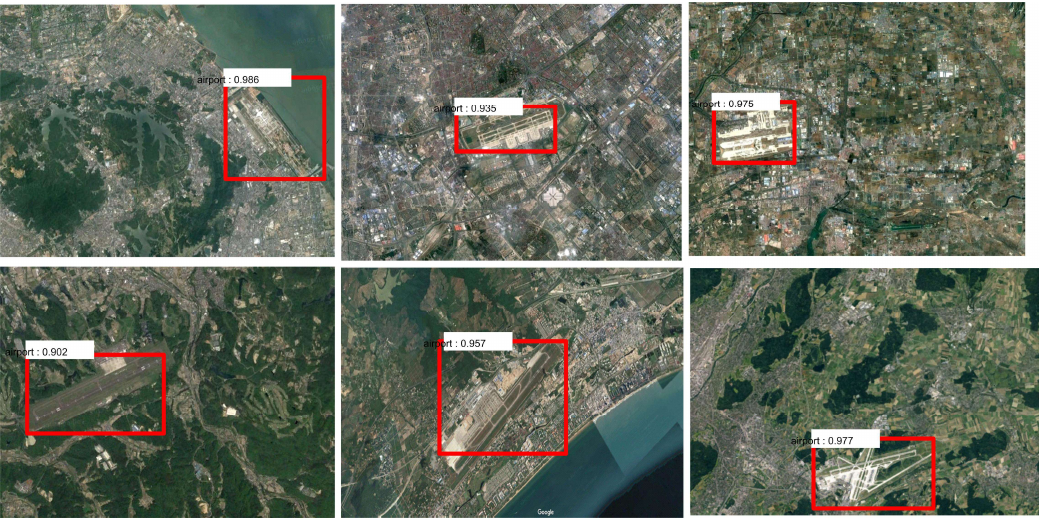
Figure 15. Airport detection results.